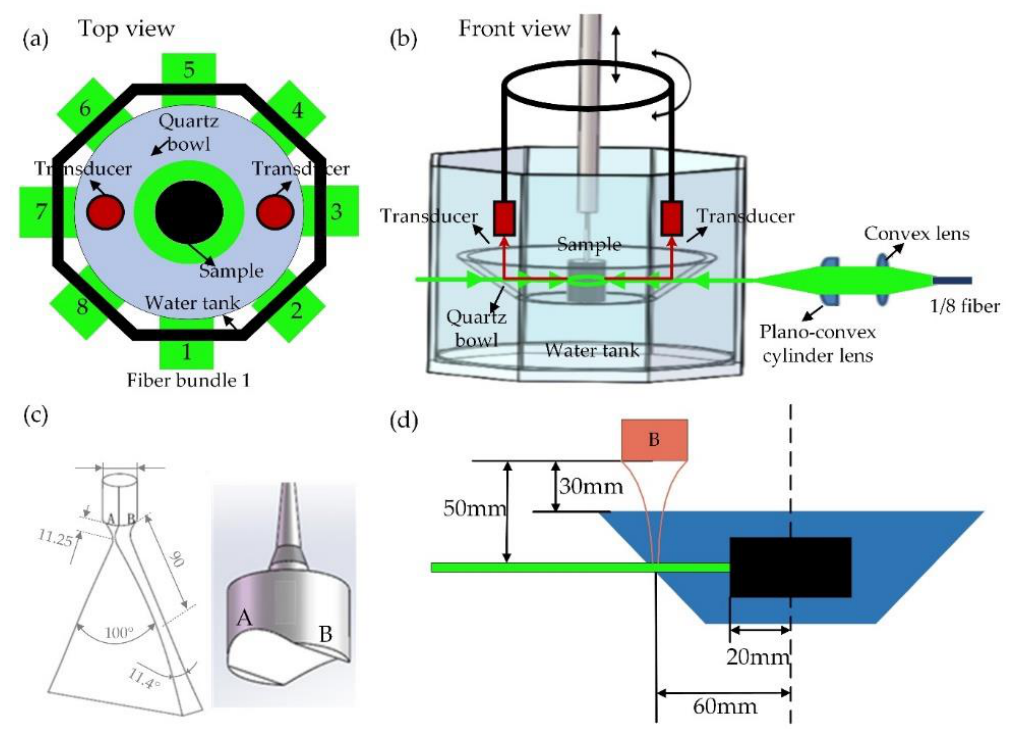
Figure 2. ( a ) Top view of the core optical path, ( b ) front view of the core optical path, ( c ) ultrasonic transducer and its size parameters, and ( d ) installation method and position diagram of ultrasonic